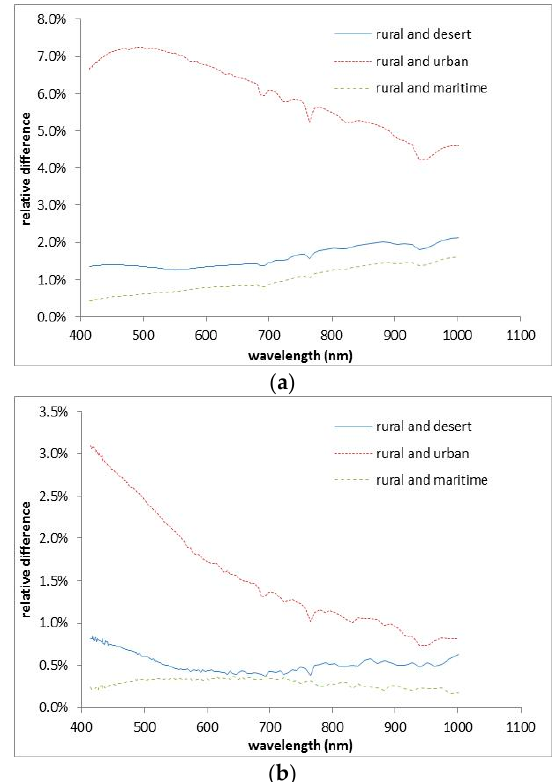
Figure 23. Relative differences in radiance using different aerosol types for the SPARK-01 calibration for 7 March 2017 using ( a ) the reflectance-based method and ( b ) the irradiance-based method. Table 4. Average relative differences in radiance for the SPARK-01 and -02 satellites.